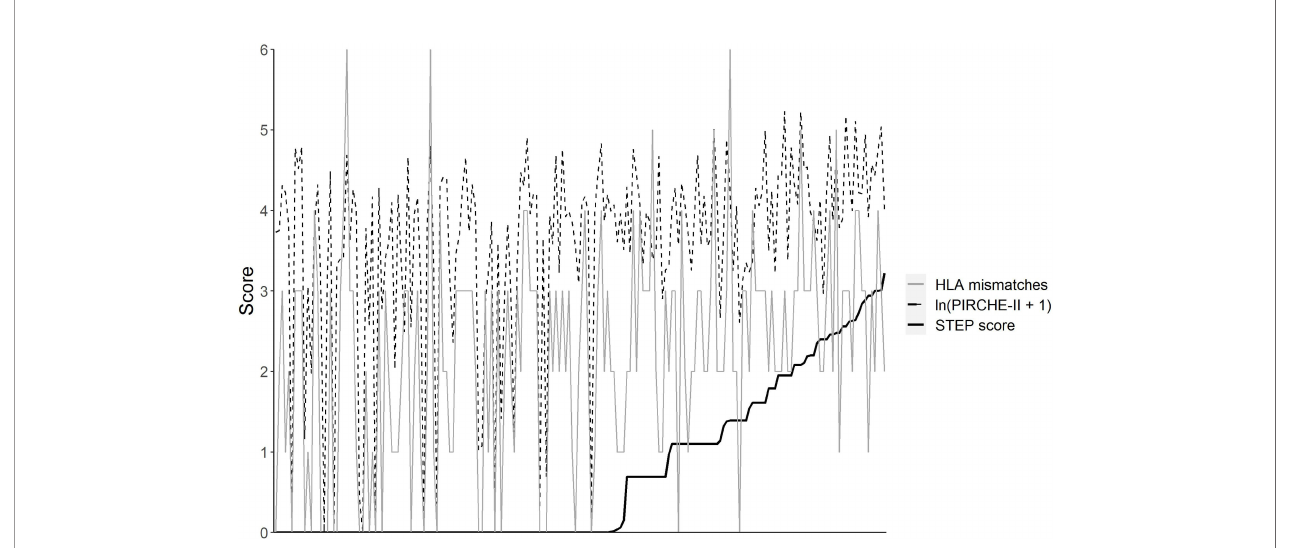
FIGURE 2 | The number of HLA-A/B/DR mismatches, the ln(PIRCHE-II + 1) score, and the STEP score of all donor/recipient couples included in this study (n = 190). Donor/recipient couples have been sorted based on increasing STEP